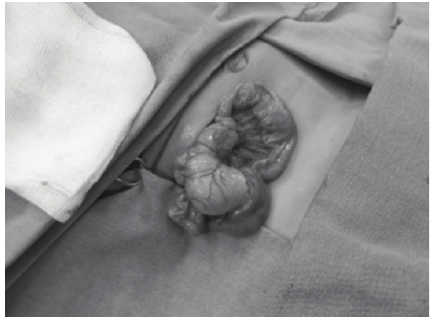
Figure 2: On exploration, a duplication cyst of 19mm, 12mm, and 5 mm in size was found at the ileal level at an approximate distance of 45 cm from the ileocecal